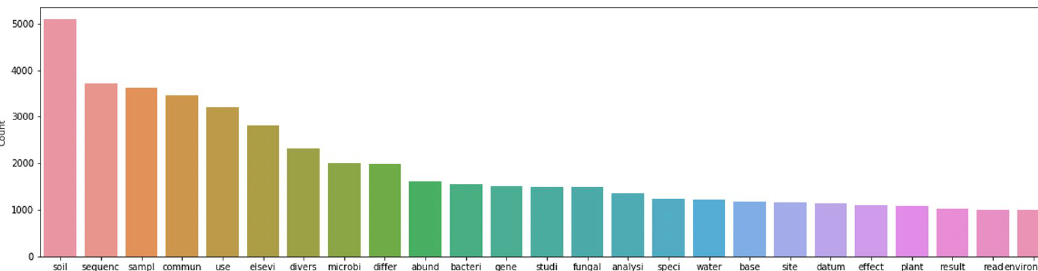
Fig 5. Count of the most common words across papers positive and negative. excludes stopwords. Our results show that “crop”, “miner”, “manag-”, “forest-”, “litter”, “fertil-”, “wheat”, “contamin-”, “amend-”, and “root” have the highest association probabilities in the assignment of articles from groups of positive or negative hit papers to topics. The figure is a sample representation of the most popular words found across the text corpus that were statistically relevant after filtering for occurrences. This reveals a potential association between the most common words and environments that contain soil and rhizosphere. Only words above a count of 1000 shown.